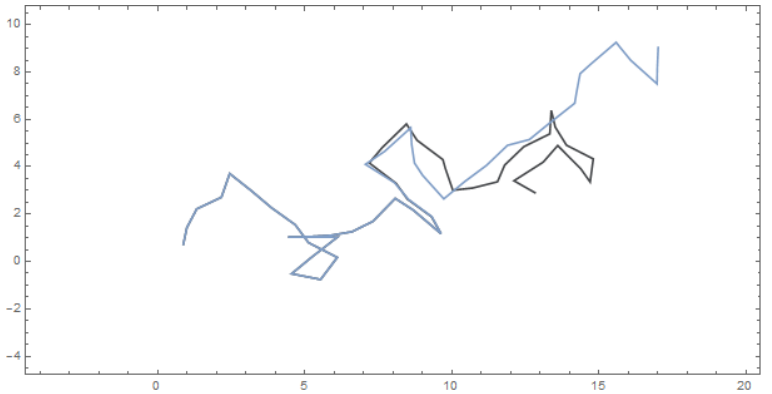
Figure 6. For parameters b = − 0.97 and d = 0, the initial conditions s x ,0 = 0.8718539083, s y ,0 = 0.7322656727 and (cid:101) s x ,0 = s x ,0 + 10 − 11 , (cid:101) s y ,0 = s y ,0 + 10 − 11 lead to different trajectories after few